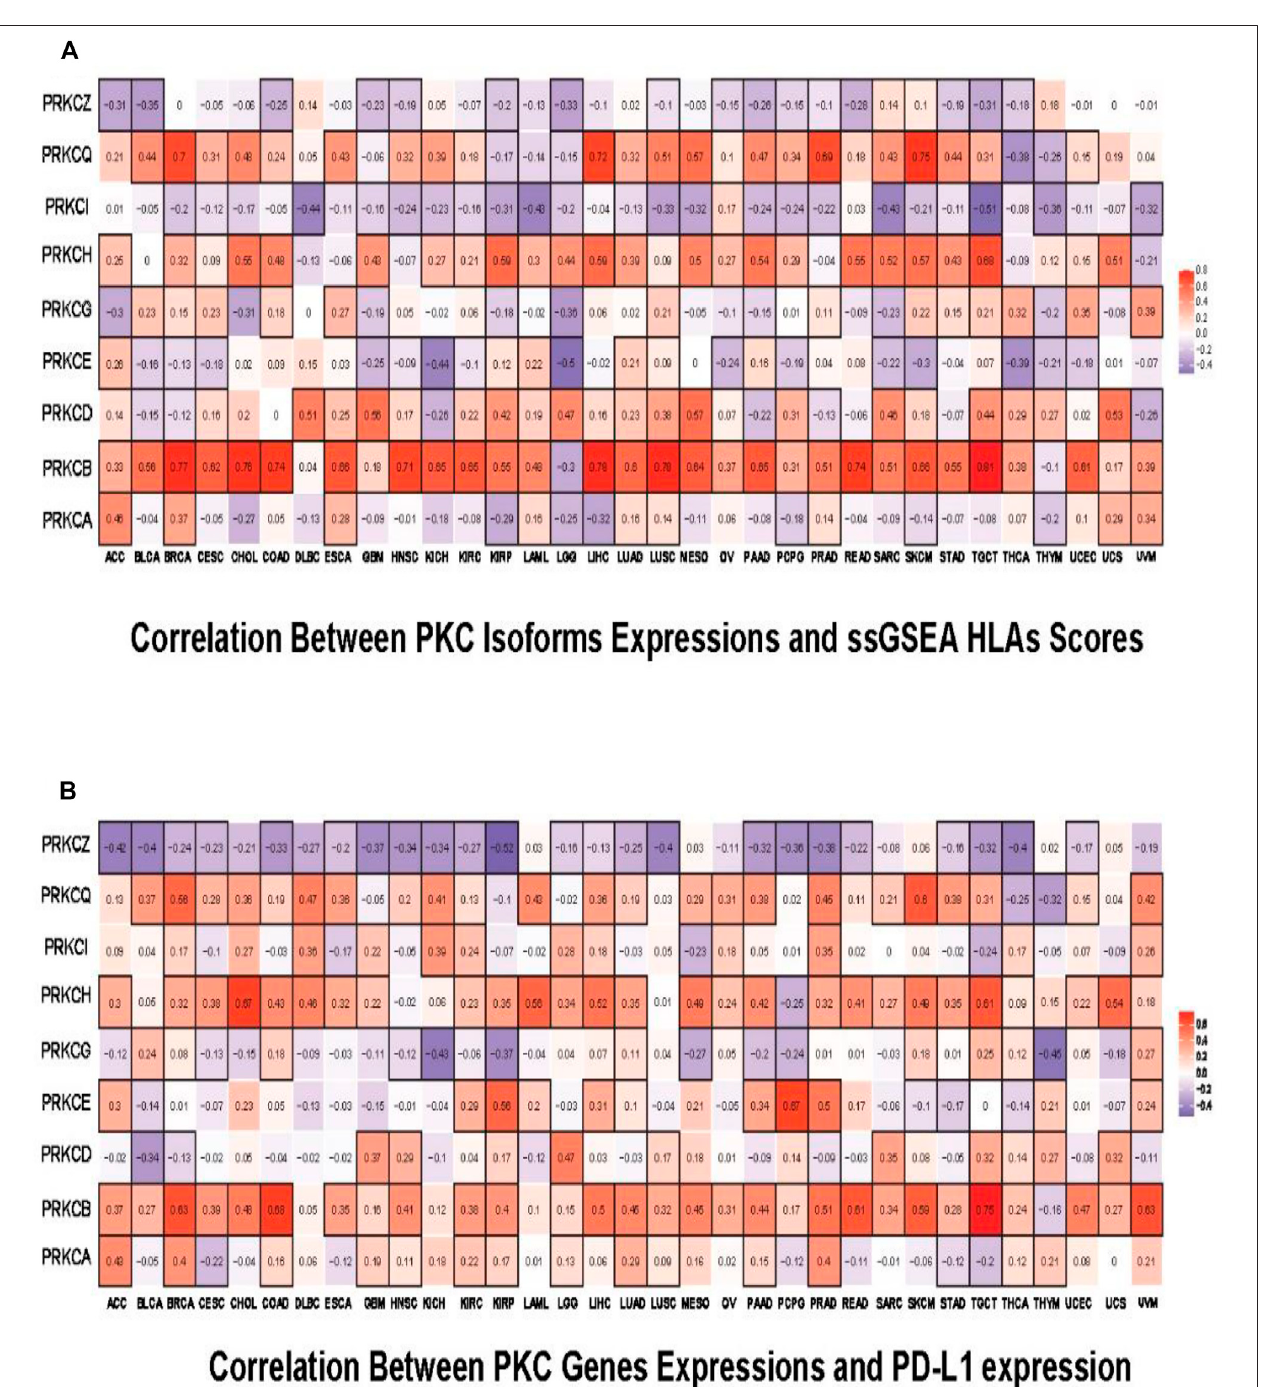
FIGURE8| Pan-cancerpredictiveanalysisfortheeffectofPKCfamilyonpatient ’ sresponsetoimmunotherapies. (A) CorrelationofPKCisoformsexpressionsand ssGSEA HLAs scores. (B) Correlation of PKC genes expressions and PD-L1 expression. The color refers to correlation coef fi cients, and the black border refers to the statistically signi fi cant correlation ( p -value < 0.05).